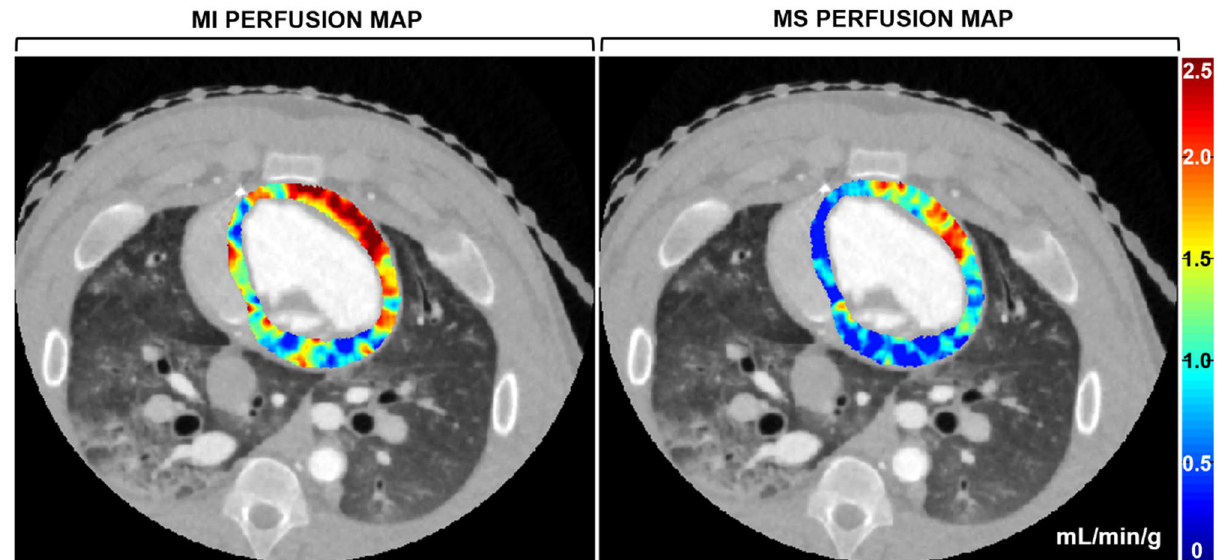
Figure 3. Motion-immune (MI) versus motion-susceptible (MS) perfusion mapping. For a single acquisition in the presence of motion without registration, MI perfusion mapping (left panel) produced accurate hyperemic perfusion measurements in the LAD territory, i.e., the anterior left ventricular wall, while corresponding MS perfusion mapping (right panel) underestimated perfusion measurements in the LAD territory, as well as globally. Images are displayed as axial views. The color bar indicates quantitative perfusion in milliliters per minute per gram of